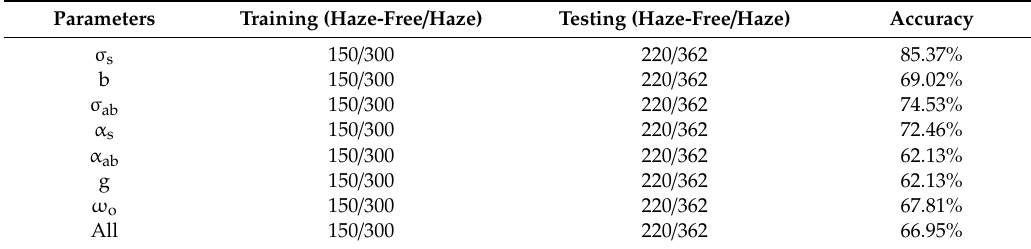
Table 3. The SVM classification accuracies of every aerosol optical parameter. σ s is the aerosol scattering absorption coe ffi cient at 520 nm (Mm − 1 ); α s is the aerosol scattering Ångström exponent at 450–700 nm;